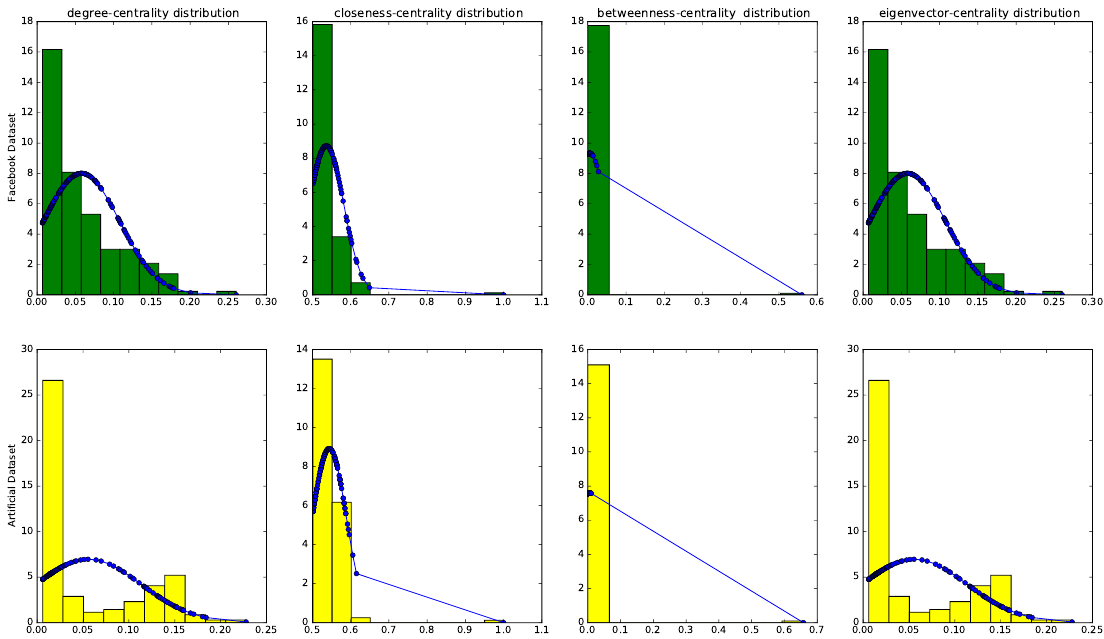
Figure 1. Centrality distribution for ego ’686’ in the Facebook graph and ego ’25’ in the artificial